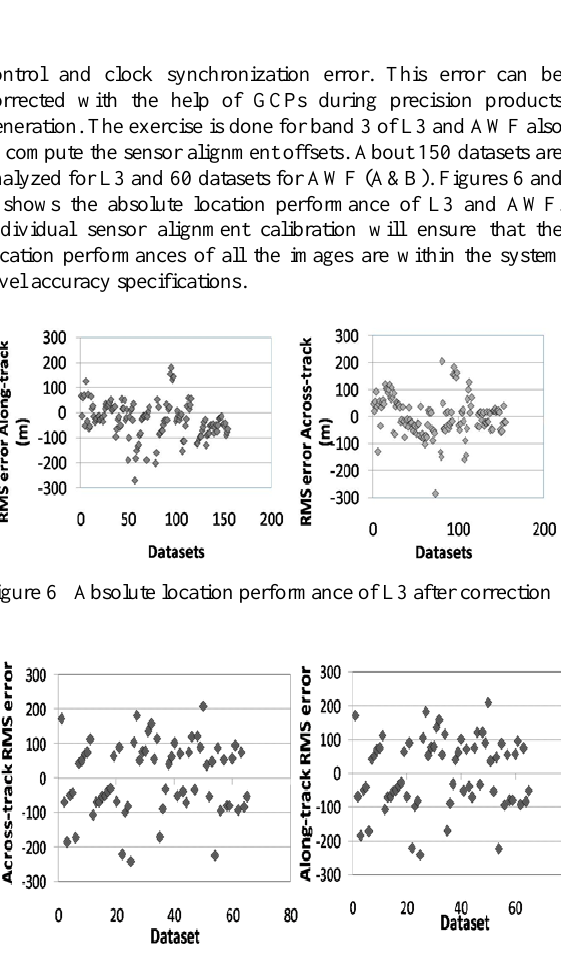
Absolute location performance of L4 (a) before